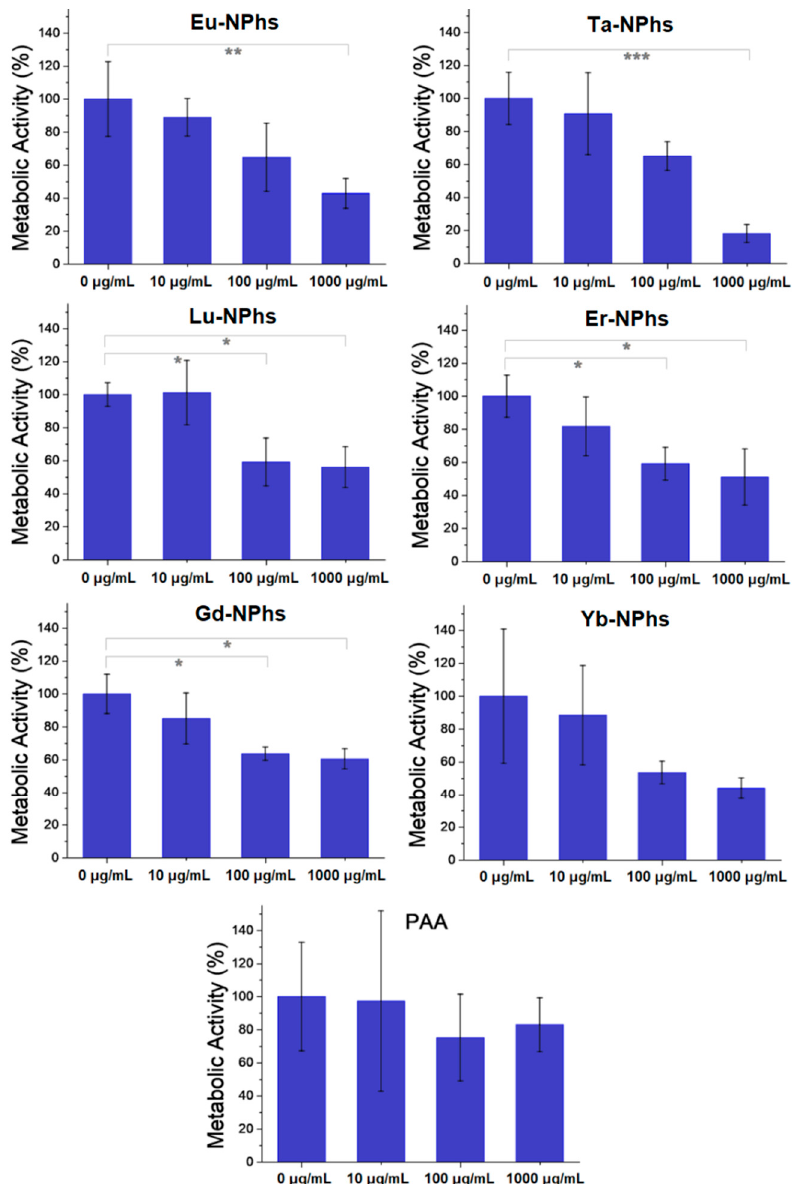
Figure 4. Metabolic activity (%) of the human lung epithelial carcinoma cell line A549 with PAA-stabilized NPhs. Cells were incubated with 0, 10, 100, and 1000 μ g/mL of PAA-stabilized NPhs (Eu, Ta, Lu, Er, Gd, Yb) as well as with the stabilizer (PAA) itself for 24 h at 37 °C; * p < 0.05, ** p < 0.01 and *** p < 0.001.